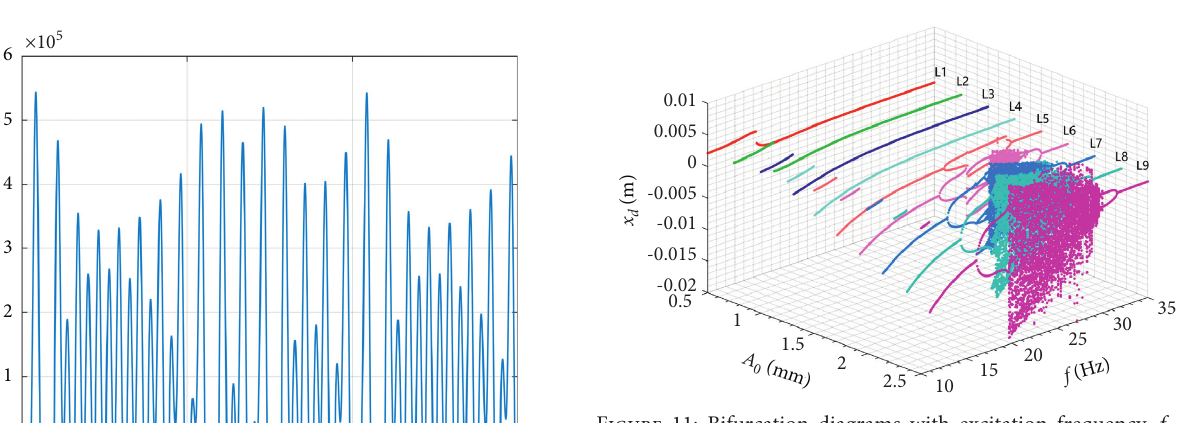
Figure 9: Dynamic responses of the rigid drum ( k Poincare